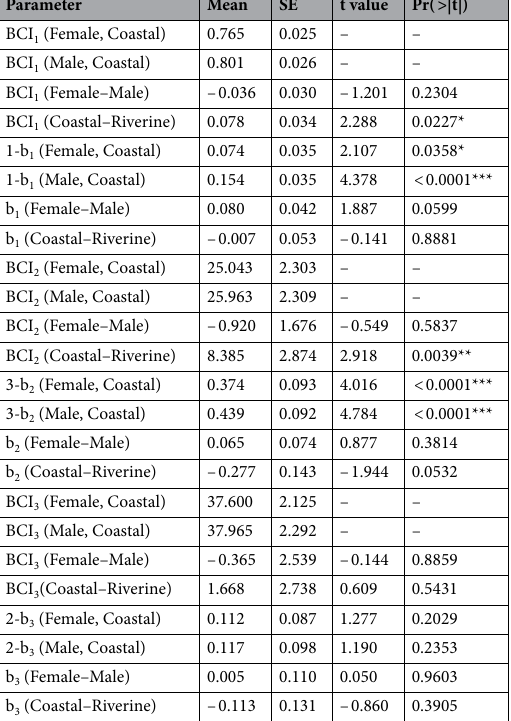
Table 3. BCI and b values fitted to wild Antillean manatees with non-linear robust regression. (* = p < 0.05; ** = p < 0.005; *** = p < 0.0005).